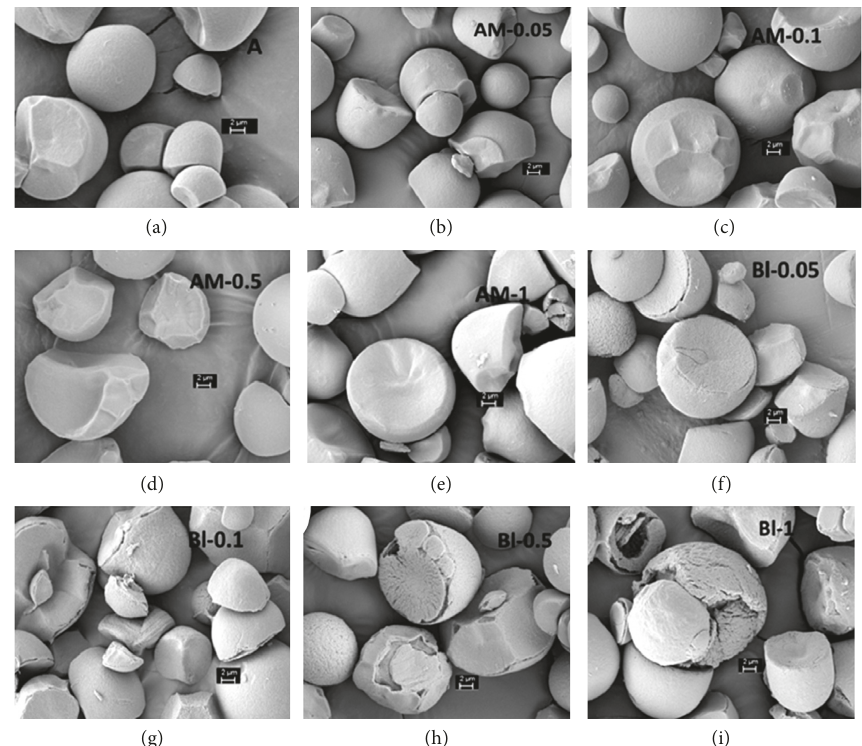
Figure 2: SEM microphotographs of native (a) and fermented modified potato starches (bar is 2 µ m): (b) AM-0.05, (c) AM-0.1, (d)